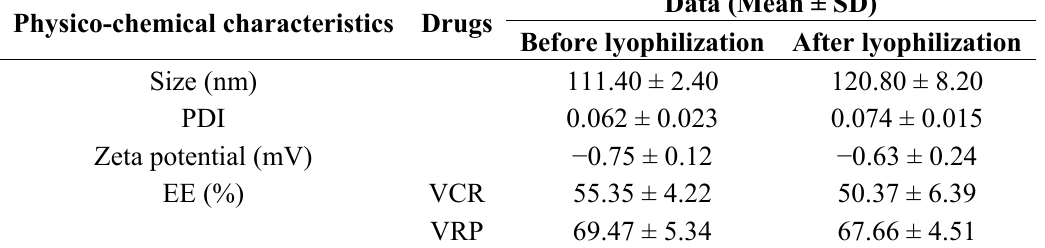
Table 2. Physico-chemical characteristics of VCR-VRP-PLGANPs before and after lyophilization ( n =